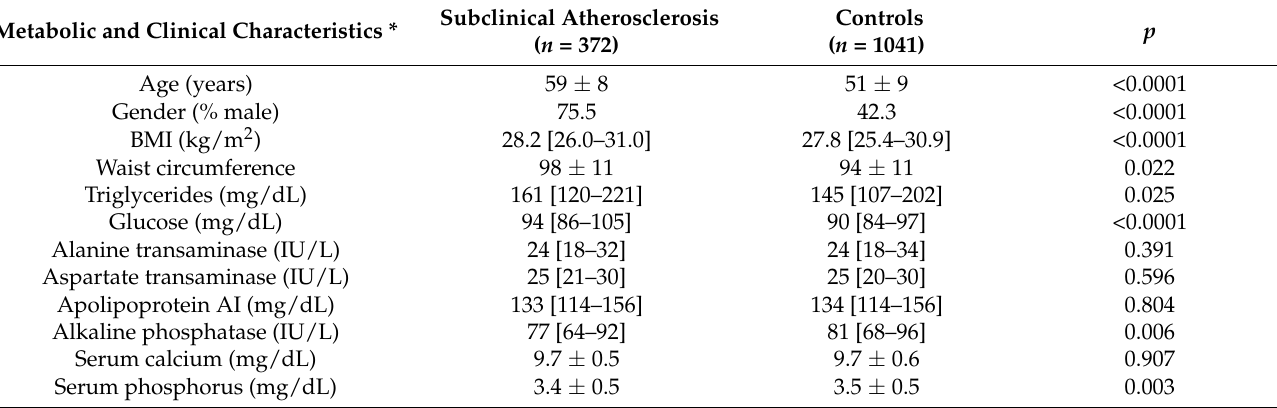
Table 1. Characteristics of studied